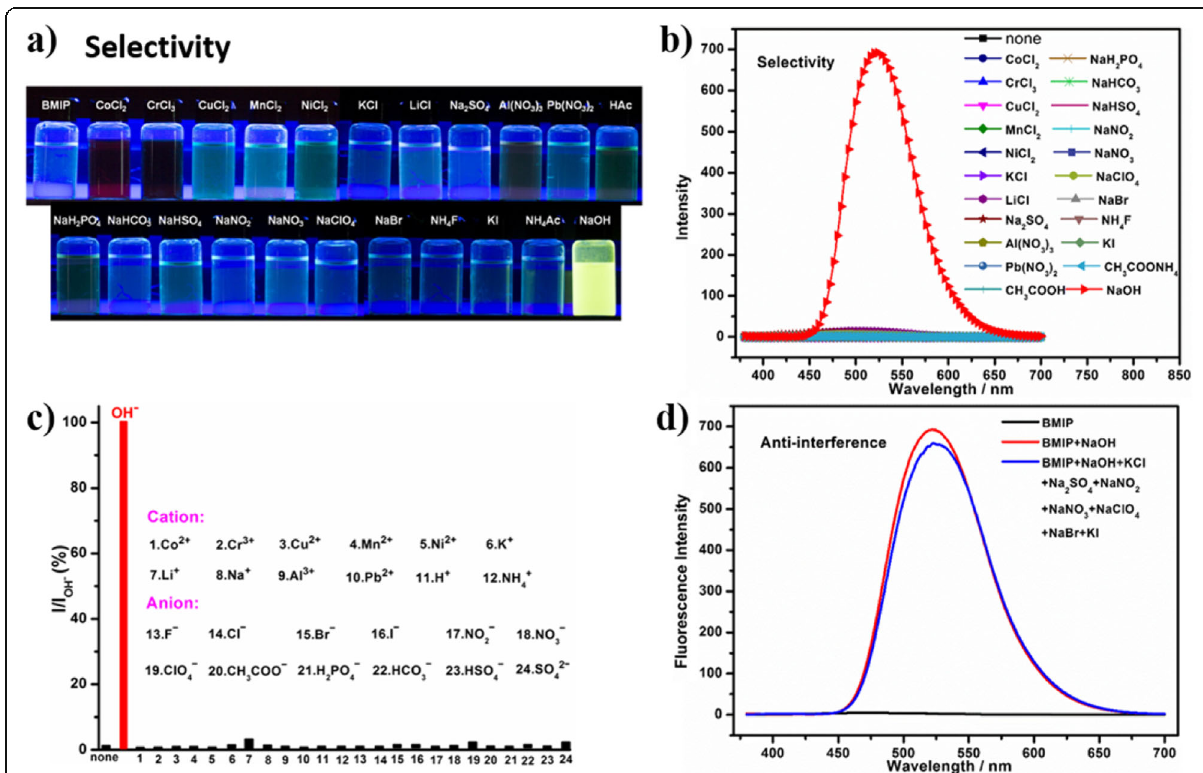
Fig. 2 a Photo comparison (under UV light) (365 nm) and b the PL spectra of aqueous solutions (1 mmol/L) of BMIP before and after the additions of different salts (CoCl 2 , CrCl 3 , CuCl 2 , MnCl 2 , NiCl 2 , KCl, LiCl, Na 2 SO 4 , Al (NO 3 ) 3 , Pb (NO 3 ) 2 , CH 3 COOH, NaH 2 PO 4 , NaHCO 3 , NaHSO 4 , NaNO 2 , NaNO 3 , NaClO 4 , NaBr, NH 4 F, KI, CH 3 COONH 4 , NaOH, respectively) (3 mol/L). c The I/I OH ˉ ratios of fluorescence responses of BMIP solutions (1 mmol/L) before and after the additions of different ions (Co 2+ , Cr 3+ , Cu 2+ , Mn 2+ , Ni 2+ , K + , Li + , Na + , Al 3+ , Pb 2+ , H + , NH 4+ , F ˉ , Cl ˉ , Br ˉ , I ˉ , NO 2 ˉ , NO 3 ˉ , ClO 4 ˉ , CH 3 COO ˉ , H 2 PO 4 ˉ , HCO 3 ˉ , HSO 4 ˉ , SO 42 ˉ , and OH ˉ , respectively) (3 mol/L) in water ( I OH ˉ represents the fluorescence intensity of BMIP solution after the addition of OH ˉ (3 mol/L), I represents the fluorescence intensities of BMIP solution before and after the additions of other ions). d The PL spectra of aqueous solutions (1 mmol/L) of BMIP at different conditions (black line, BMIP solution without any additives; red line, BMIP solution after adding NaOH (3 mol/L); blue line, BMIP solution after adding NaOH, KCl, Na 2 SO 4 , NaNO 2 , NaNO 3 , NaClO 4 , NaBr, and KI (3